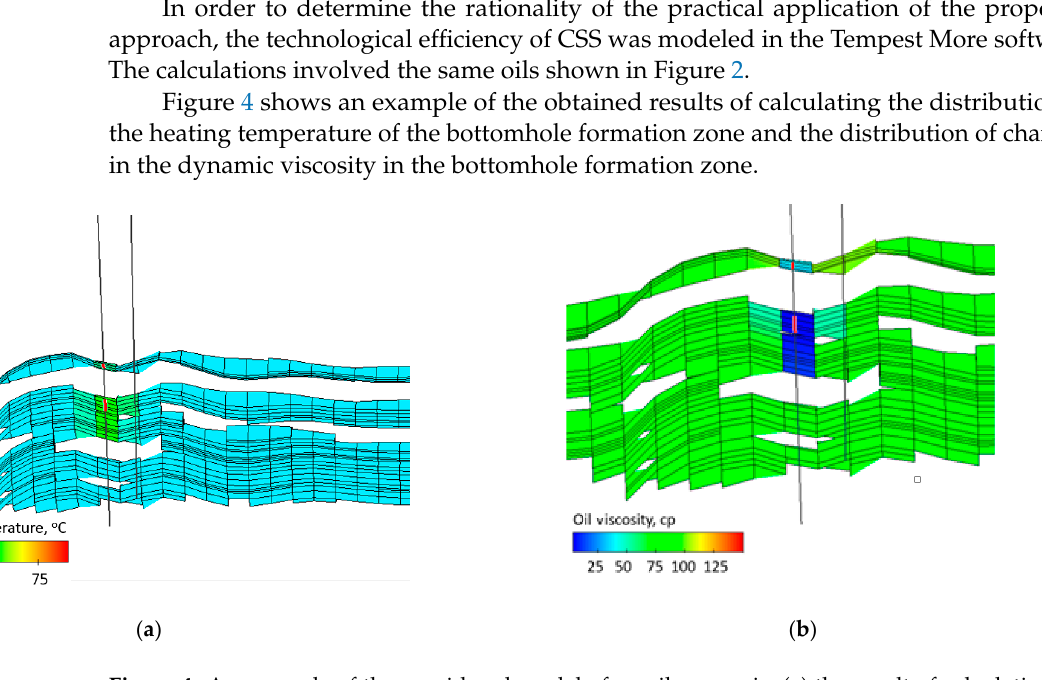
Table 4. Results of calculations of cumulative oil production before and after near-wellbore CSS technology application based on case study.